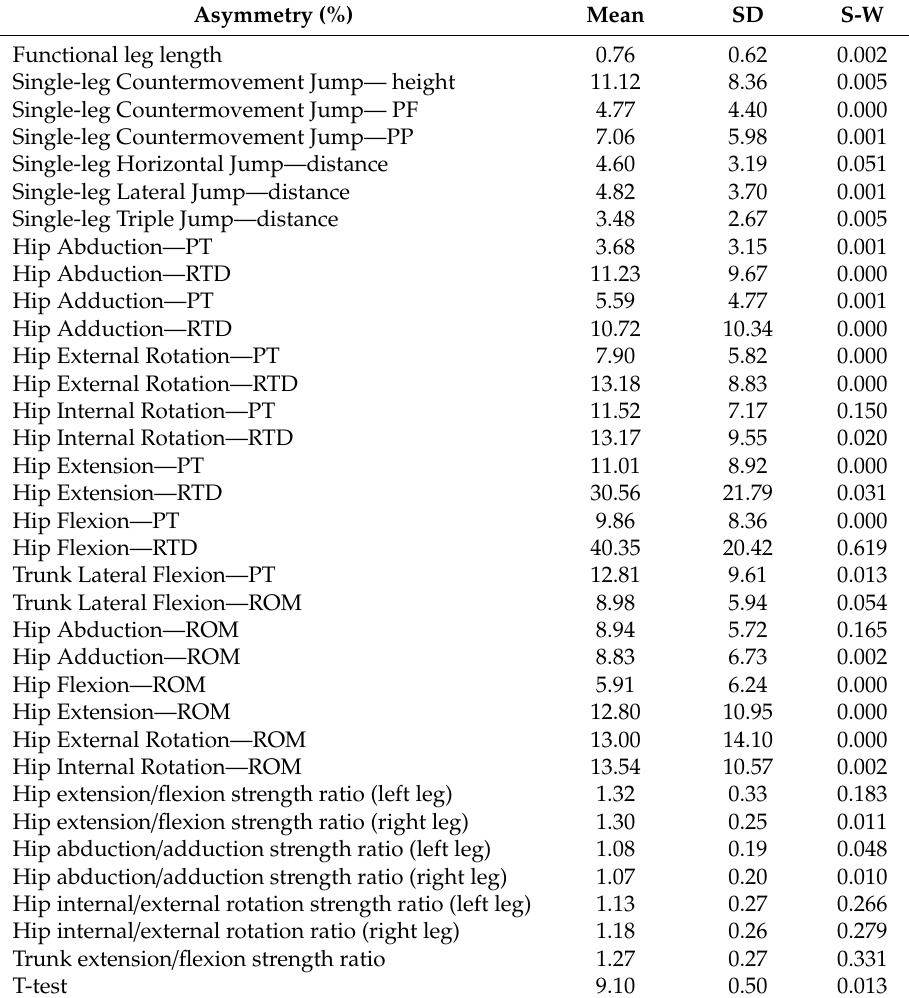
Table 2. Descriptive and normality analysis of asymmetry variables.